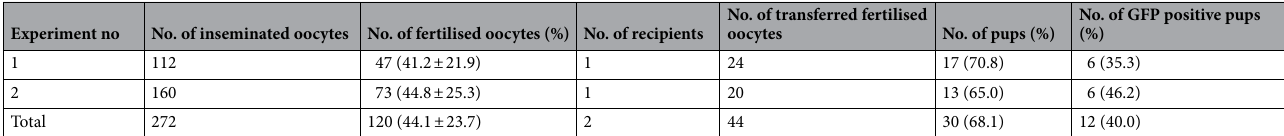
Table 2. Fertilisation rate and birth rate of cold-transported rat sperm. In the IVF, 6 female and 2 male rats were used. Ten vasectomised male rats and 2 pseudo-pregnant rats were used for embryo transfer.